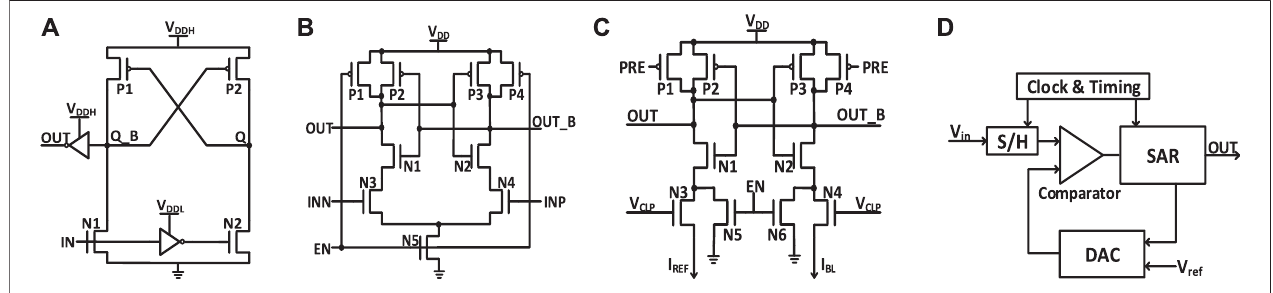
FIGURE 2 | Schematics of (A) level shifter; (B) voltage sense ampli fi er (VSA); (C) current sense ampli fi er (CSA); (D) successive approximation register (SAR) ADC.